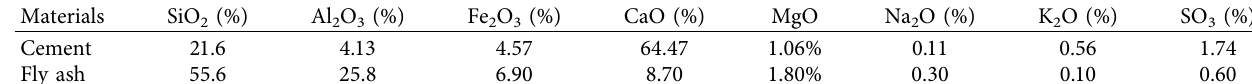
Table 1: Composition of cement.